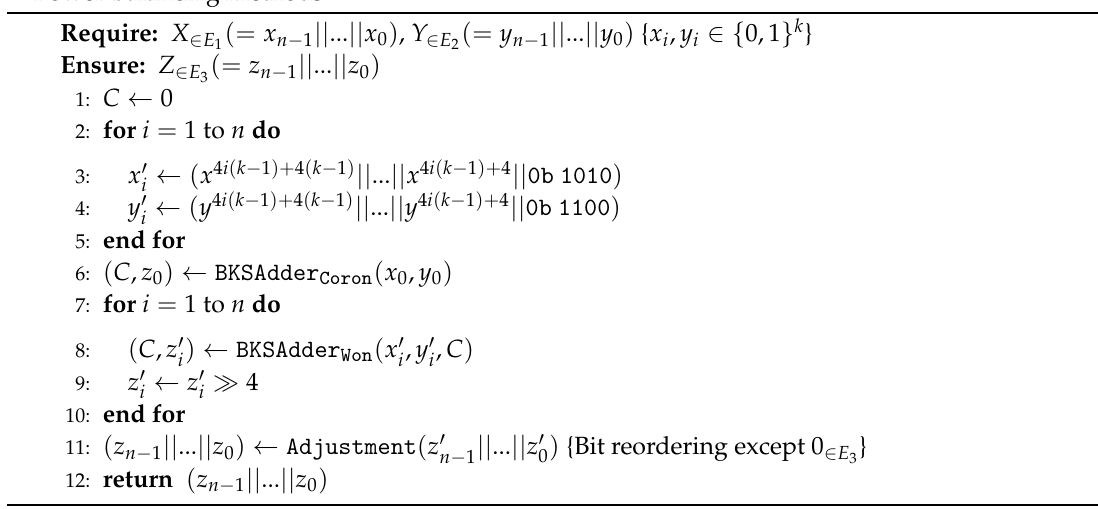
Algorithm A6: Multi-bit Adder Combining Won’s Kogge–Stone Adders Applied to Power-balancing